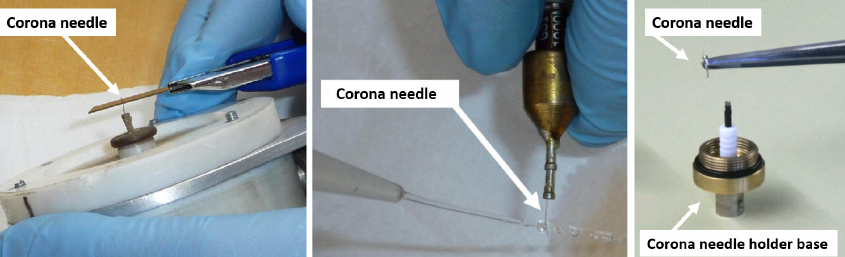
Figure 14. Cleaning the corona needle with a sharp knife (left) or by rinsing with a dissolvent (middle), and replacing a corona needle using tweezers (right).